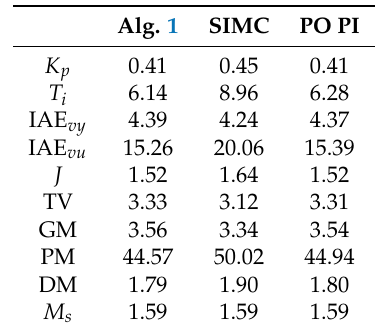
Table 6. Example 2. Consider PI control of the IPTD process model, H p ( s ) = e − s the controller parameter, indices and margins are given for prescribed robustness M s = 1.59 for the following methods: Alg. 1 (¯ c = 2.5, δ = 1.79), SIMC ( T c = 1.24 τ ) and PO PI ( M s = 1.59).